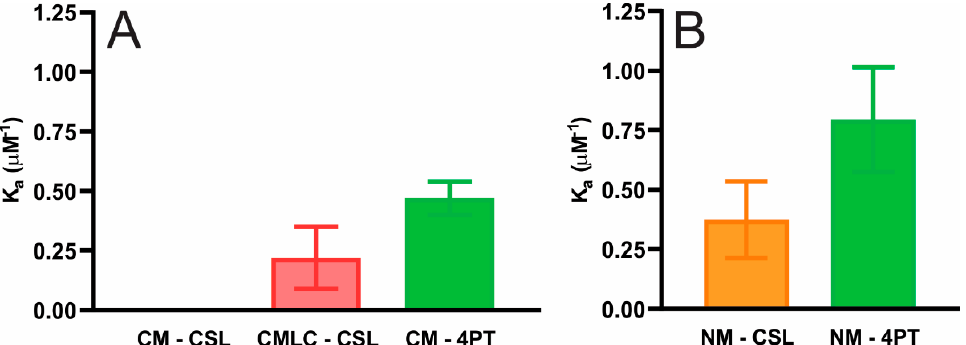
Figure 2. ( A ) Showing the binding affinity (K a ) of α -crystallin to the bovine CMs with the CSL and 4PT spin-labels within these membranes and the CMLC with the CSL spin-label within the membrane. ( B ) Demonstrating the K a of α -crystallin binding to the bovine NMs with the CSL and 4PT spin-labels within these membranes. The K a below the surface of the CM detected by the CSL spin-label is zero, implying that the CSL spin-label does not detect α -crystallin binding to the CM. However, the K a below the surface of the CMLC detected by the CSL spin-label within the membrane is non-zero, implying that decreasing Chol content within the membrane increases the strength of α -crystallin binding to membranes. The NMs have higher K a than the CMs with both the CSL and 4PT spin-labels and the difference is statistically significant with p ≤ 0.05. Results are the mean ± standard deviation ( σ ) from at least three independent